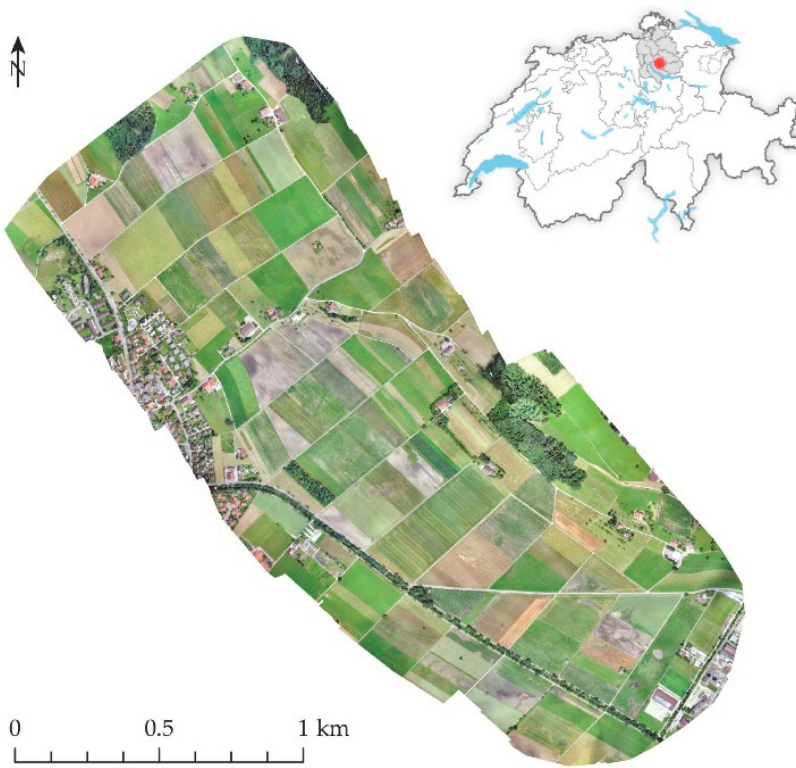
Figure 1. Outline of the study area (near Mönchaltorf, Switzerland). (See overview map of Switzerland, top right) in the Canton of Zurich, acquired with a spatial resolution of 0.05 m using a consumer-grade RGB (red, green, and blue) camera mounted on an unmanned aerial vehicle (UAV). Table 1. Crop classes present in the study area and their respective field characteristics.